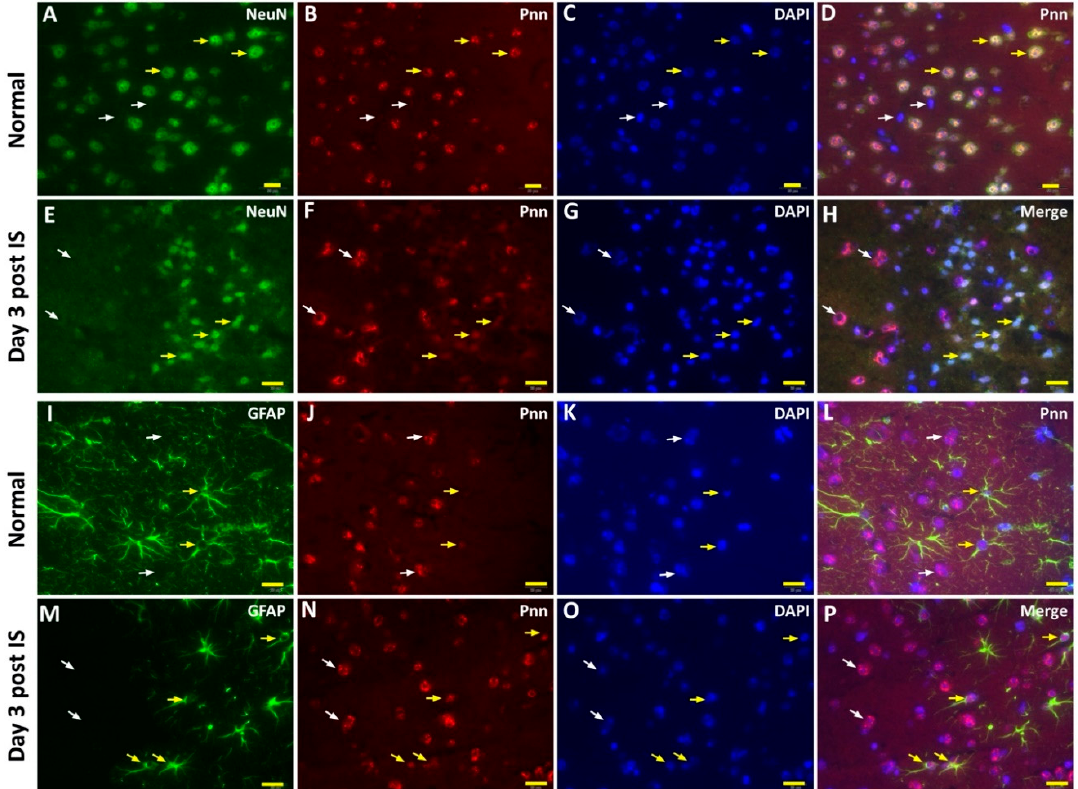
Figure 5. The cell type-specific distribution of Pnn in the mouse cerebrum after induction of ischemic stroke. Immunofluorescent stainings were performed to detect the expression and distribution of Pnn, a neuron nuclear antigen (NeuN), and glial fibrillary acidic protein (GFAP, a marker of astrocyte and ependymal cells) in cerebrum 3 days post ischemic stroke. ( A – D ) Distribution of Pnn in neurons of normal control cerebral cortex. ( E – H ) Distribution of Pnn in neurons of cerebral cortex with ischemic stroke. ( I – L ) Distribution of Pnn in astrocytes of normal control cerebral cortex. ( M – P ) Distribution of Pnn in astrocytes of cerebral cortex with ischemic stroke. Yellow arrows in ( A ) to ( H ) indicate the expression of Pnn in NeuN + neurons. White arrows in ( A ) to ( H ) indicate the expression of Pnn in non-neuron cells. Yellow arrows in ( I ) to ( P ) indicate the expression of Pnn in GFAP + astrocytes. White arrows in ( I ) to ( P ) indicate the expression of Pnn in non-astrocyte cells. Scale bars in left lower corner of indicate 20 μ m.